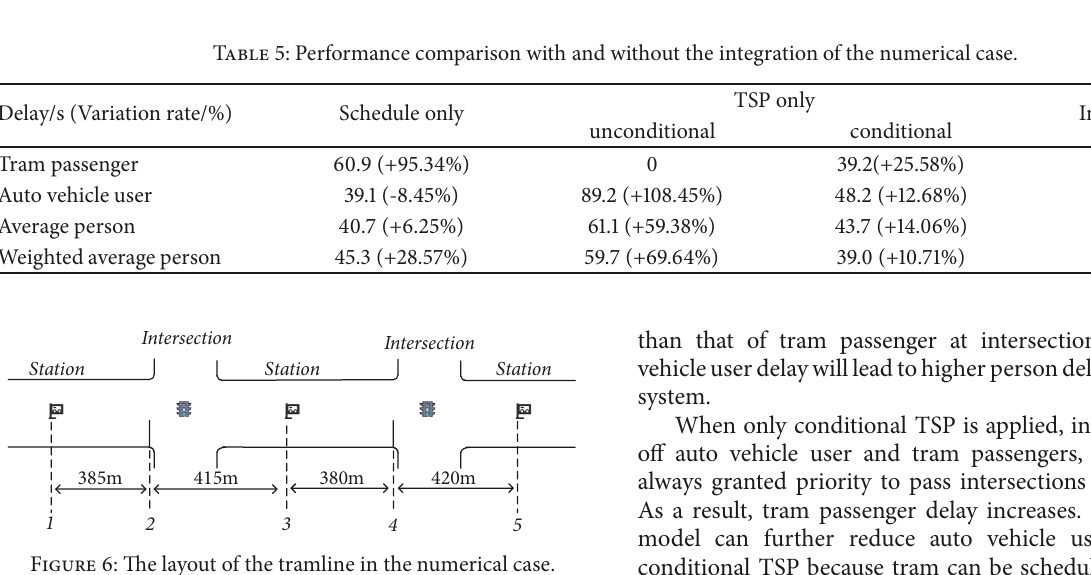
delay. Due to travel time limits between each link, only adjusting tram schedule is not able to reduce delay for tram passengers and each person of the whole